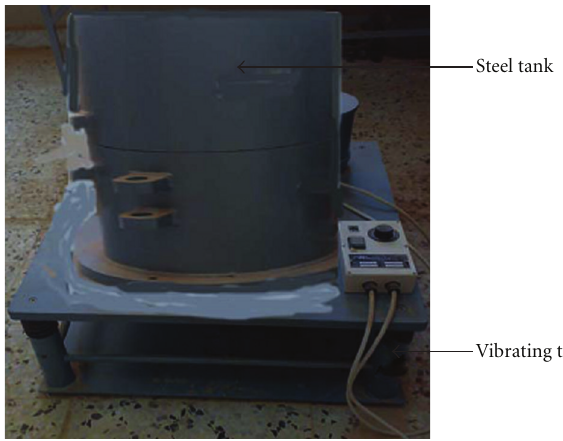
Figure 1: Test set up and soil tank rested on the vibrating